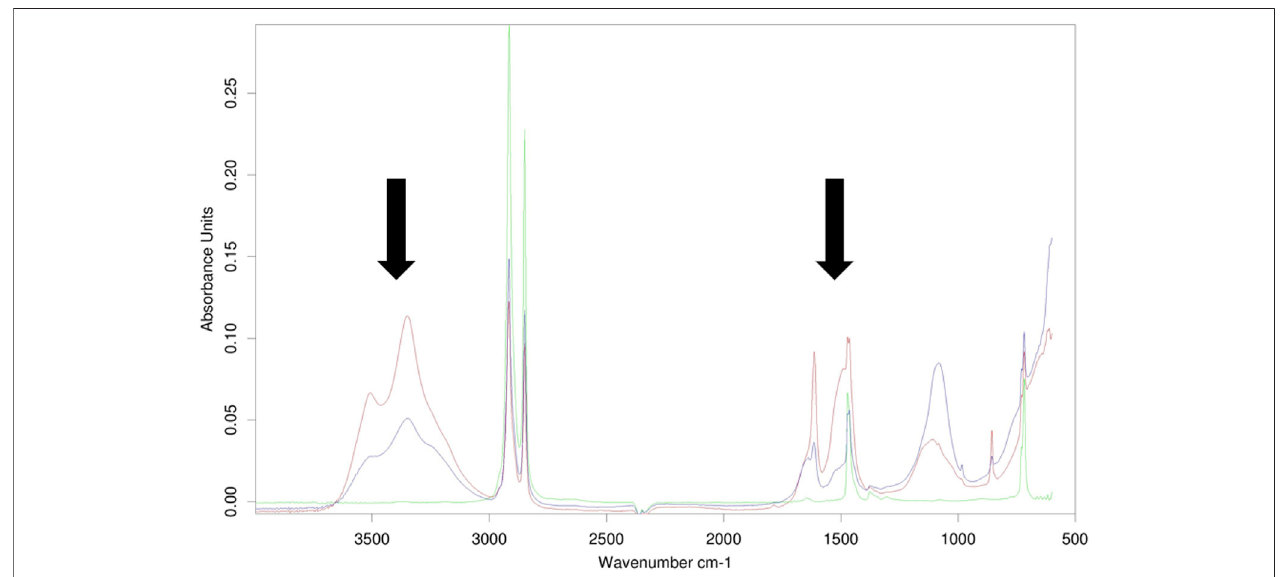
FIGURE3| FT-IRspectralcomparisonofreferenceandexposedLDPE fi lms.Thegreenlinerepresentsthereferencespectrum,whiletheredandblacklinesdepict the spectra of LDPE fi lms after exposure. Peaks around 1,650 cm − 1 and 3,300 cm − 1 are highlighted by arrows.